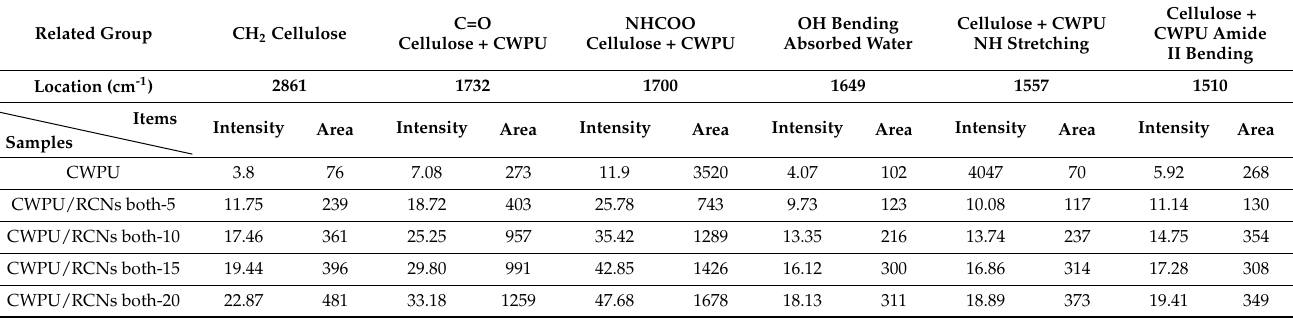
Figure 5. ( a ) Particle size and zeta potential measurement, ( b ) viscosity properties, and ( c ) FTIR spectra of the prepared CWPU and CWPU/RCNs nanocomposite dispersions according to RCNs contents. Table 4. Curve-fitting results of FTIR peak assignments for CWPU and CWPU/RCNs nanocomposite dispersions according to RCNs contents in Figure